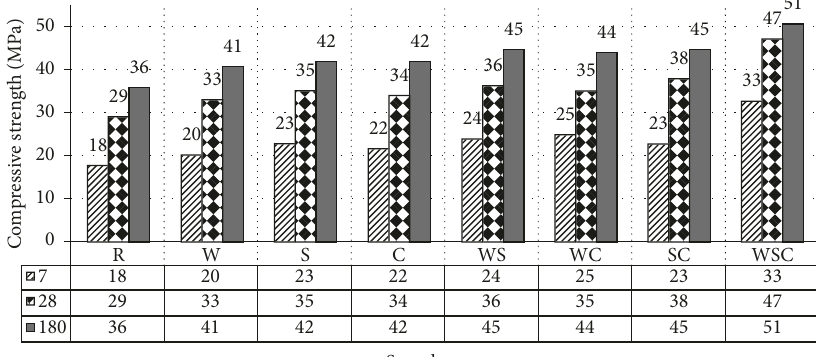
Figure 5: Compressive strengths of the samples kept in tap water.